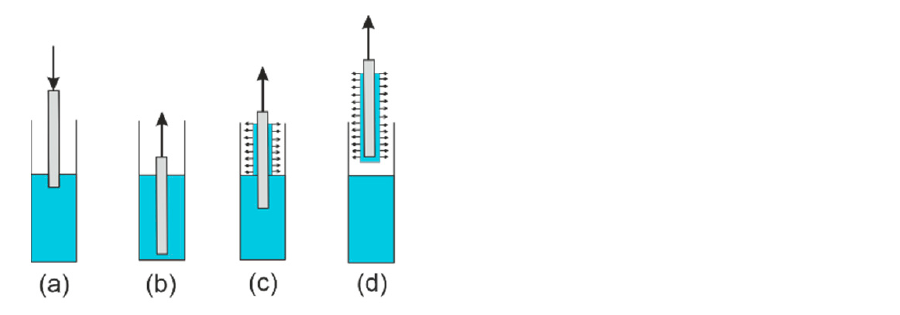
Figure 2. The stages of dip-coating technique. ( a ) Dipping the substrate in the sol, ( b ) beginning of the withdrawal, ( c ) withdrawal of the substrate from the sol, ( d ) pre-drying the layer. In the above equations, the evaporation process of solvents was not taken into account. It should be emphasized that the thicknesses of the films in the drying and annealing processes undergo contraction and they are generally much smaller than the thicknesses of sol films immediately after their application [48]. In practice, the proportionality coefficient A and slope α change with the aging time of the sol [47]. These coefficients are determined from the approximation of experimental dependencies d = d ( v ) for the films after annealing, and they are used to design technological processes. In Section 4 we will demonstrate that the presented here composite films SiO x :TiO y have good waveguide properties. From the optical point of view, after coating the substrate with a composite film of higher refractive index than that of the substrate, a three-film optical waveguide structure is formed on both sides of the substrate whereof the diagram is presented in Figure 3.